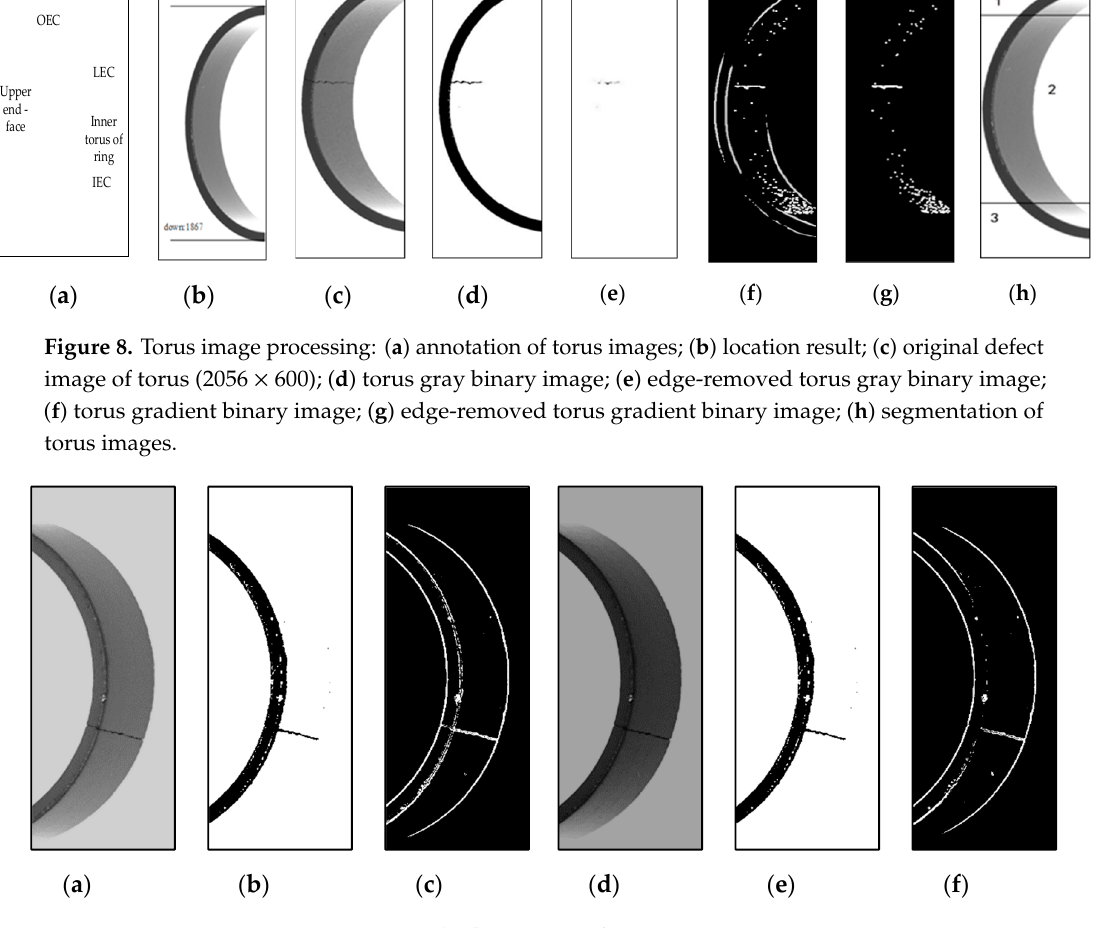
Figure 10. End face image processing: ( a ) segmentation of end face images; ( b ) end face image (2452 × 2056); ( c ) edge-removed end face image; ( d ) edge-removed end face binary image; ( e ) location result and annotation. Algorithm 1 Magnetic Ring Location Algorithm